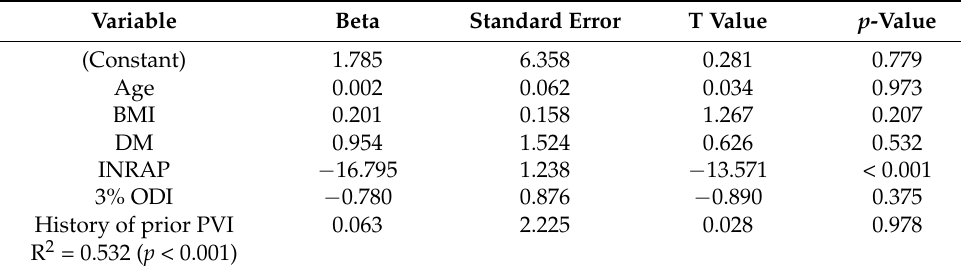
LA pressure during the inspiration period (presence of INRAP predicts the decrease in LA pressure during inspiration